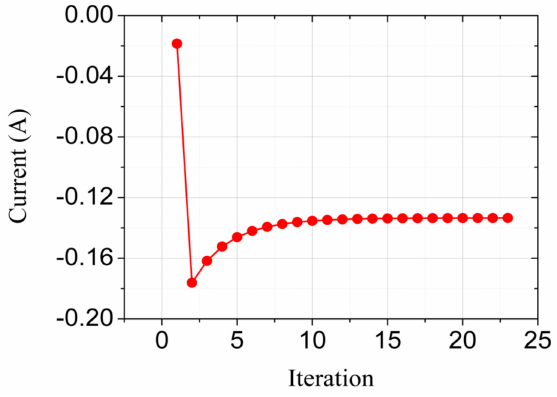
Figure 2. The convergence of the emitting current.